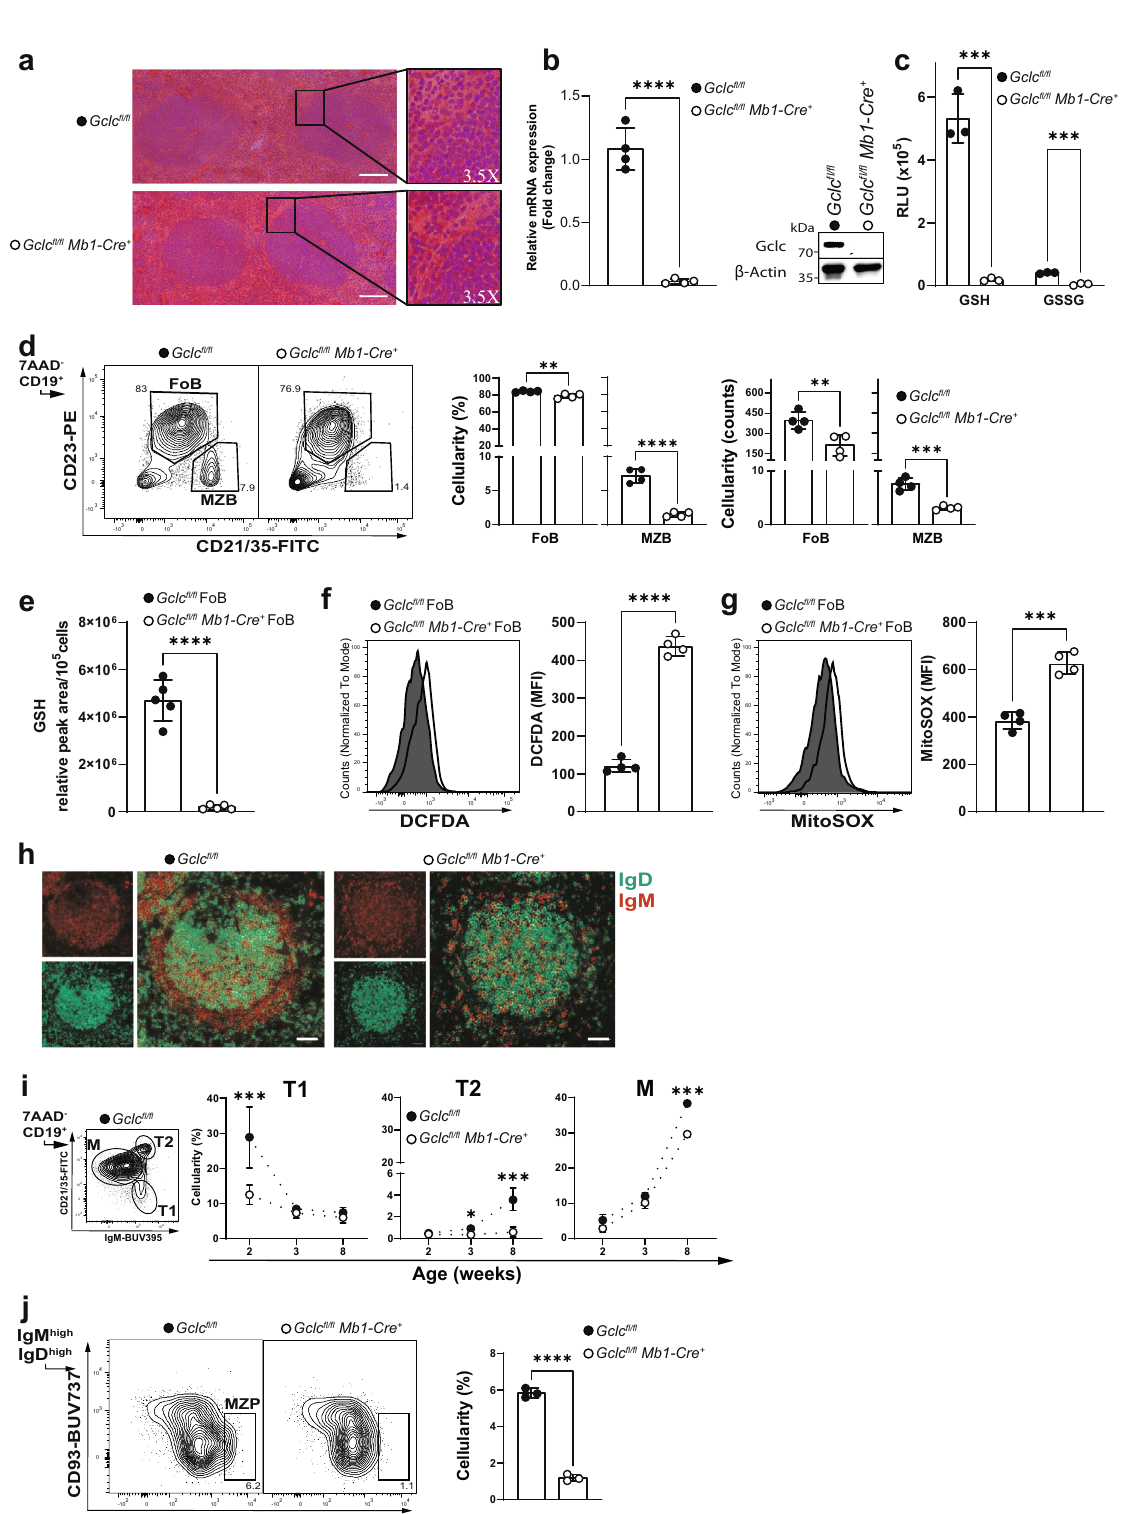
failure to detect MZB in B cell-speci fi c Gclc -de fi cient mice is not due to altered environmental cues. Instead, we have shown that in vivo ablation of Gclc in B cells caused a block in B cell differentiation, which results in the absence of MZP. This implies that the difference in redox fl exibility between FoB and MZB precursors is necessary to allow B cell differentiation.